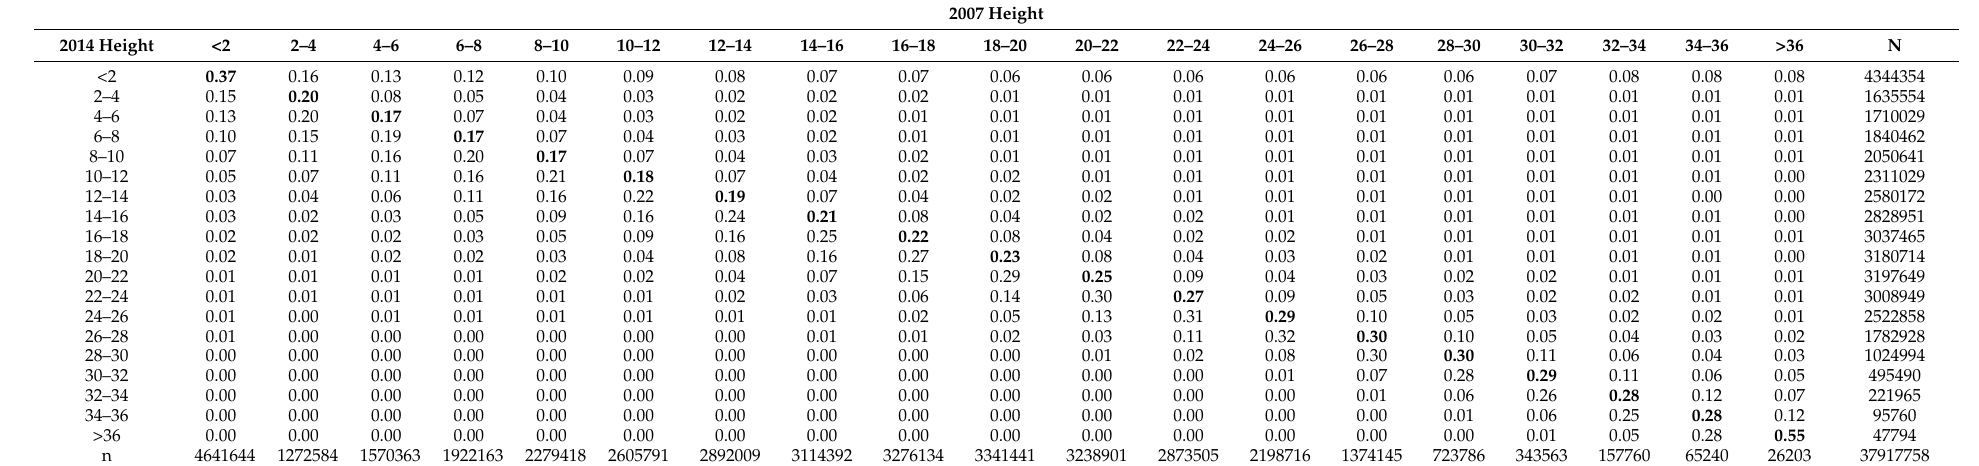
Table 5. Matrix of height transitions from 2007 to